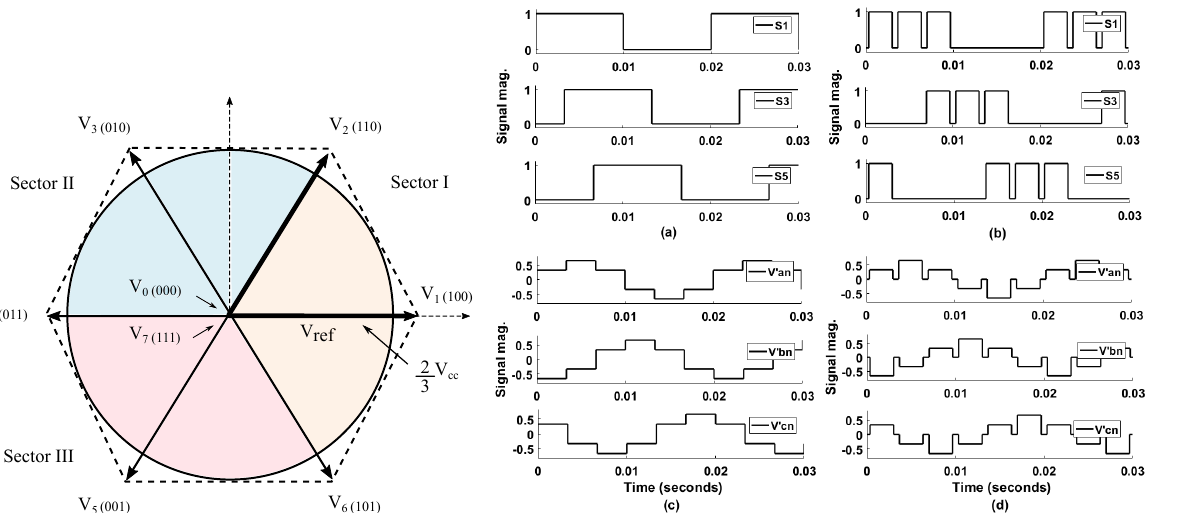
Figure 3. SVM technique for three-phase converter. ( a ) Pole voltages of upper switches (S 1 , S 3 , S 5 ) at m = 1. ( b ) Pole voltages of upper switches (S 1 , S 3 , S 5 ) at m = 0.9. ( c ) Phase voltages at m = 1. ( d ) Phase voltages at m = 0.9.